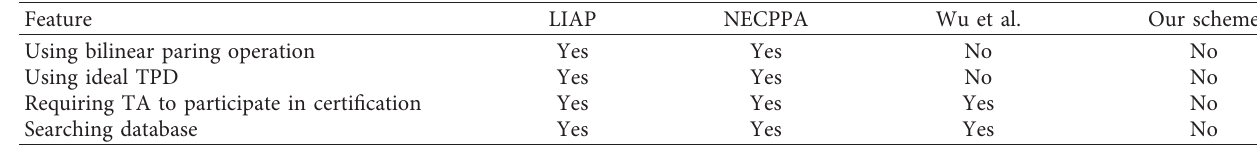
Table 2: Features comparison.